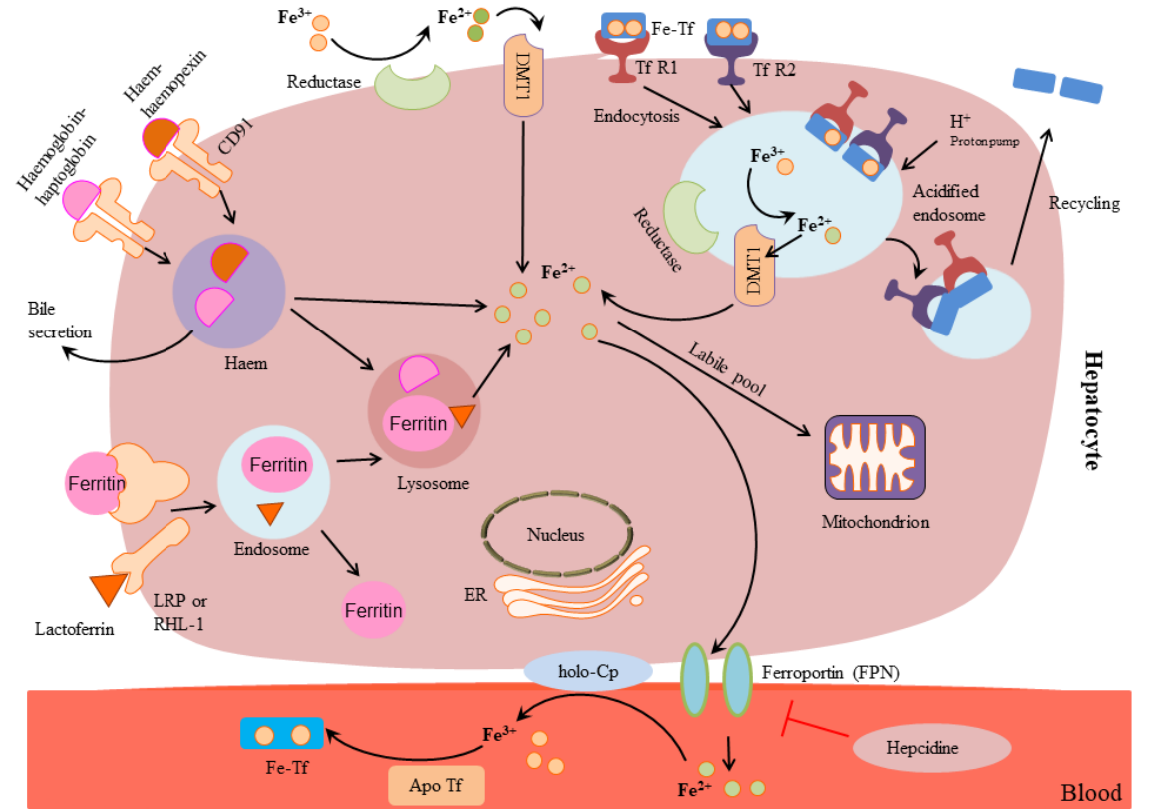
Figure 2. Iron metabolism in the hepatocyte. Iron is taken up by hepatocytes through an endocytosis mediated by the transferrin receptor1 (TfR1): TfR1 is located on the cell surface and binds to a holotransferrin (Fe-TfA) proton ATPase pump acidifies the endosome after the endocytosis, allowing Fe 3+ release from the holo-Tf. Fe 3+ are then reduced to Fe 2+ by a reductase: Fe 2+ can then pass through DMT-1. Iron is thought to form labile bonds with citrate adenosine triphosphate (ATP), adenosine monophosphate (AMP), or other peptides (labile pool) once inside into the endosome, and to reach the mitochondria. In the mitochondria, iron is used for the biosynthesis of heme and iron-sulfur clusters. It can be also stored in ferritin (the main source of reserve iron). Ferroportin accompanies excess iron, as Fe 2+ , into the blood, where ceruloplasmin (holo-Cp) oxidizes it to Fe 3+ facilitating the loading onto transferrin (Tf).